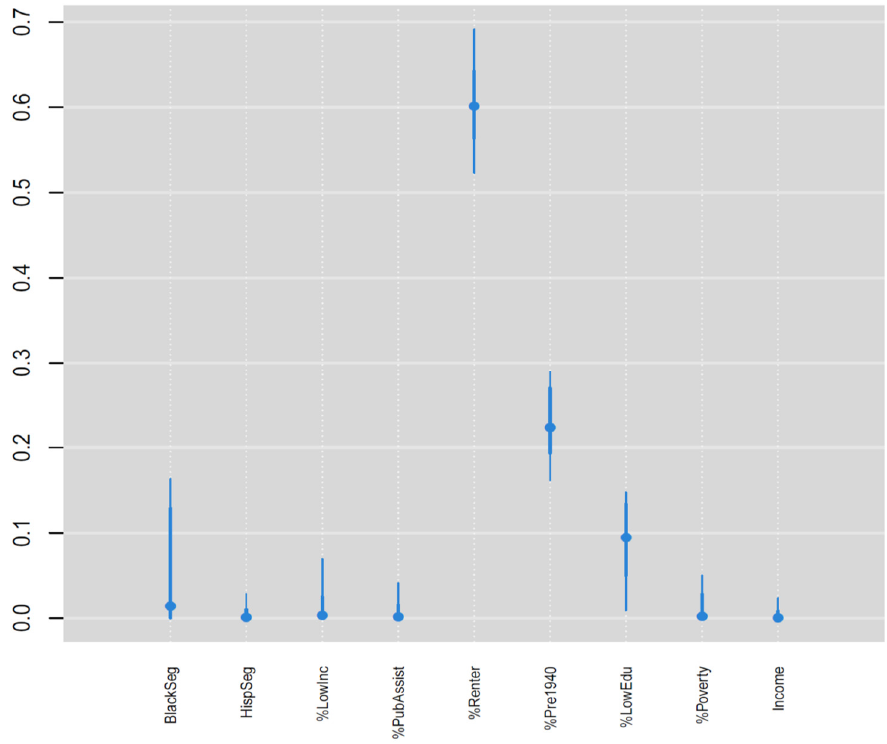
Figure 4. Posterior medians and 95% credible intervals for the neighborhood disadvantage index weights.